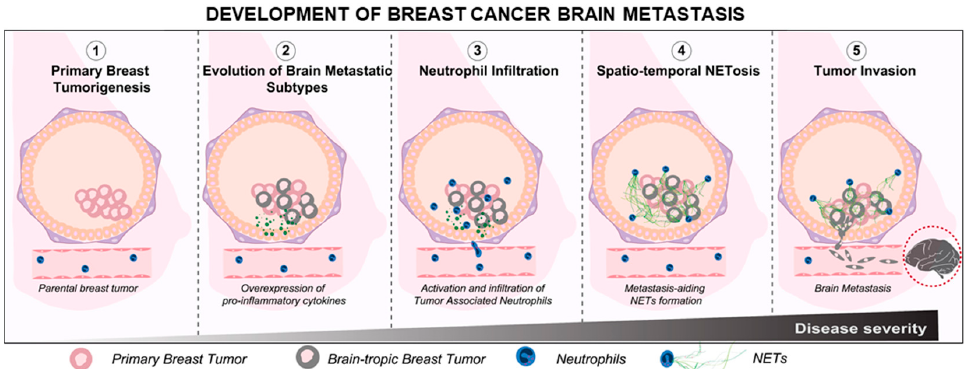
Figure 1. Schematic representation of the breast cancer brain metastasis development and the associated tumor-promoting functionalities of the neutrophils.